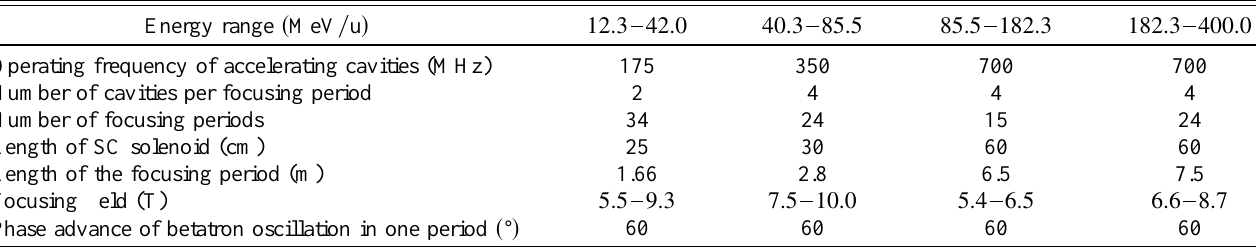
TABLE II. Focusing lattice of the driver linac.